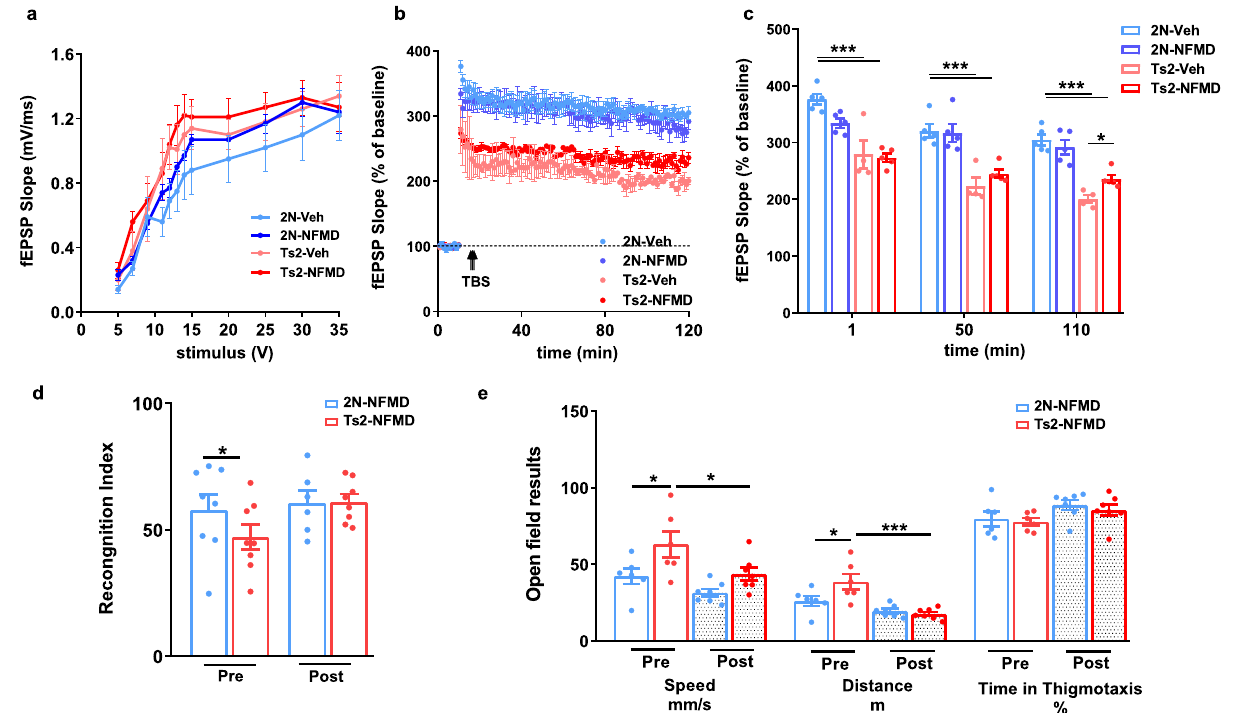
Fig. 2 | Slower decline of LTP and normalized scores of behavioral tests in Ts2 mice treated with NFMD. a Input/output relationship plots of hippocampal slices from 2N and Ts2 mice treated with either vehicle or NFMD ( n =4 mice for Ts2 groupand n =5micefortheothertreatmentgroups),andgraphedusingGraphPad Prism8.0.1 [no signi fi cant difference between the slopes, Linear regression F (3, 40)=0.107, p =0.956]. b Plots ofLTP in the Schaffer collateral synapses